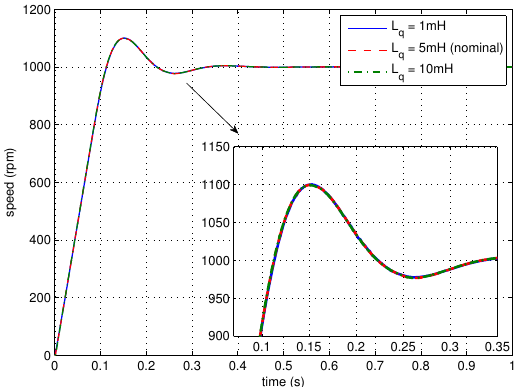
Figure 5. Tests of robustness to stator inductance uncertainties.